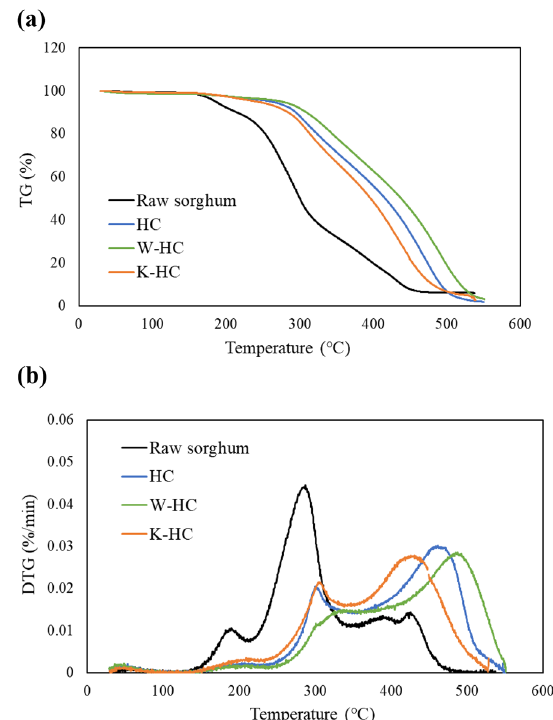
Fig. 7 a TG of raw sorghum and hydrochar at 250 °C for 3 h. b DTG of raw sorghum and hydrochar at 250 °C for 3